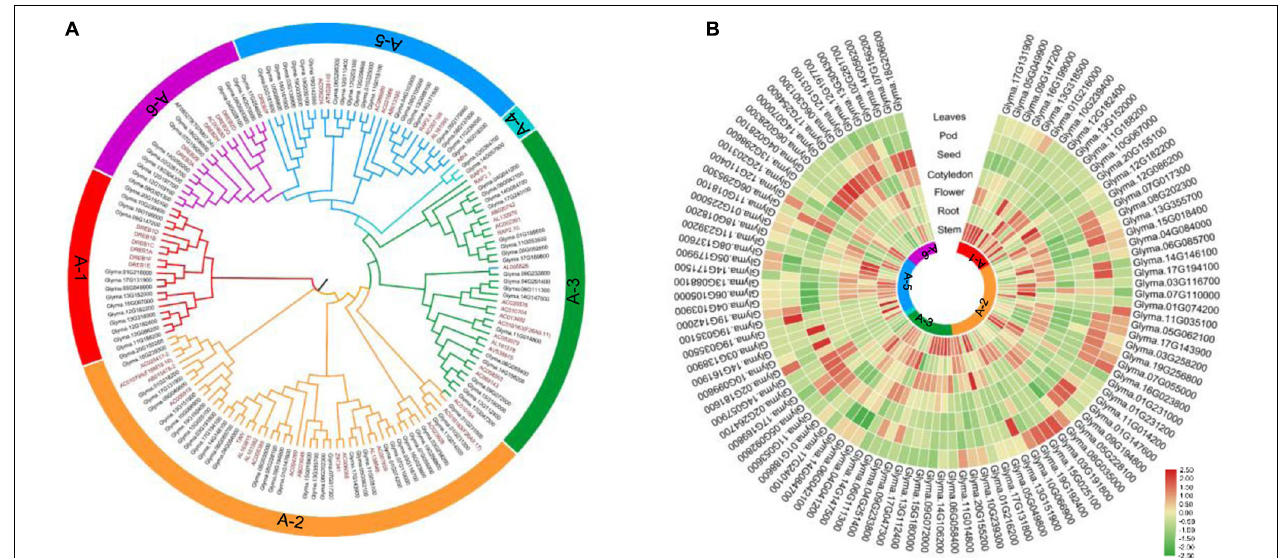
FIGURE 2 | Phylogenetic tree of the DREB genes of Arabidopsis thaliana and soybean, and gene expression profile of soybean DREB genes in different tissues. (A) The NJ tree was constructed using MEGA_X based on alignment of a total of 159 DREB proteins, including 56 Arabidopsis DREBs and 103 Glycine max DREBs. DREB subfamilies are divided into six groups (A-1 to A-6). (B) The normalized microarray expression data of 103 Glycine max DREBs was downloaded from PLEXdb (http://www.plexdb.org/). The heatmap was produced using